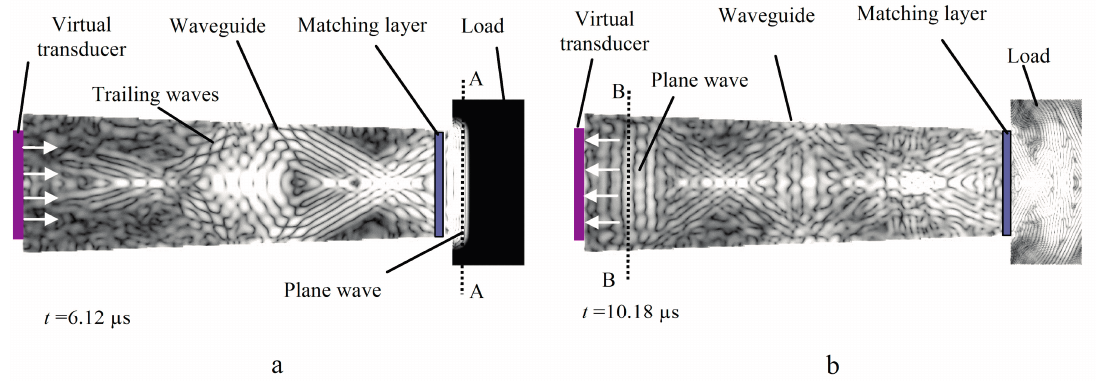
Figure 11. Displacement fields of the ultrasonic wave propagating in the tapered steel waveguides with the aluminum powder matching layer. ( a , b ) Cross-section y 0 z of the